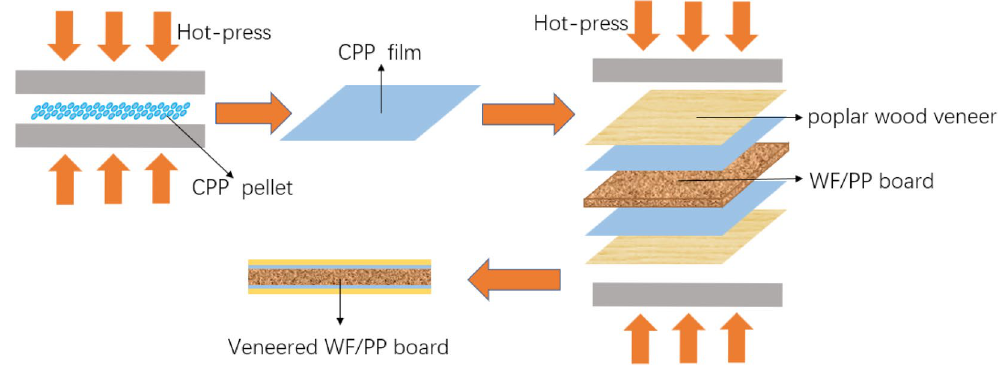
Figure 1. Preparation of veneered WF/PP board with CPP film.